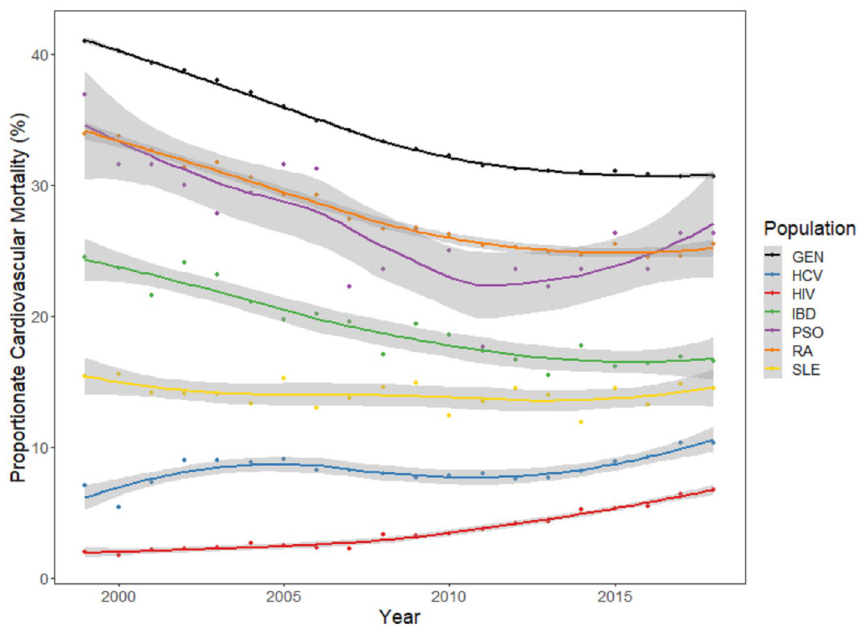
Figure 1. Proportionate cardiovascular mortality over time by disease, 1999–2018. GEN General population, HCV Chronic Hepatitis C Virus, ICD-10 code B18.2, HIV Human immunodeficiency virus, ICD-10 codes B20– 24. IBD Inflammatory bowel disease, ICD-10 codes K50–51, PSO Psoriasis, ICD-10 code L40, RA Rheumatoid Arthritis, ICD-10 codes M5–M6, SLE Systemic lupus erythematous, ICD-10 code